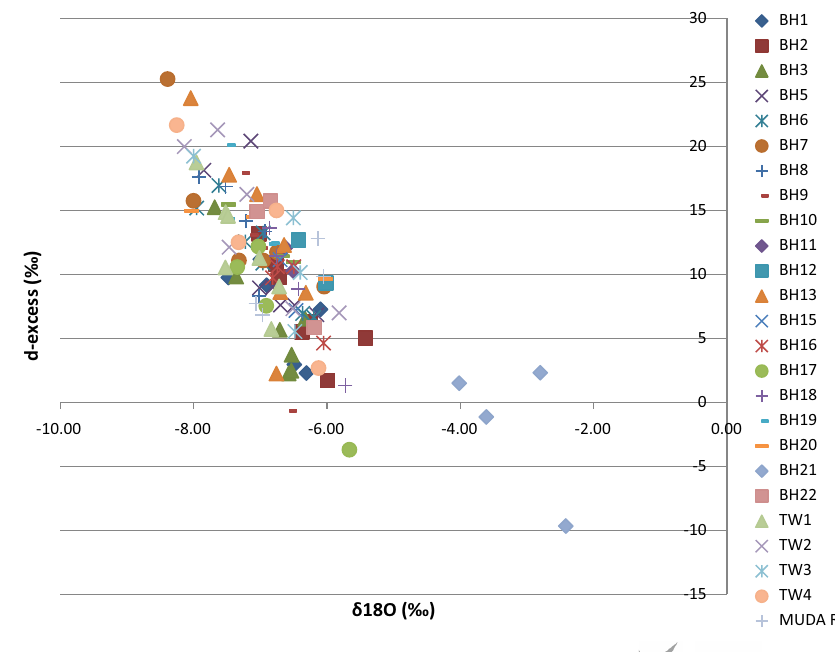
Fig. 7 Relationship between δ 18 O (‰) and d-excess for Lower Muda River Basin